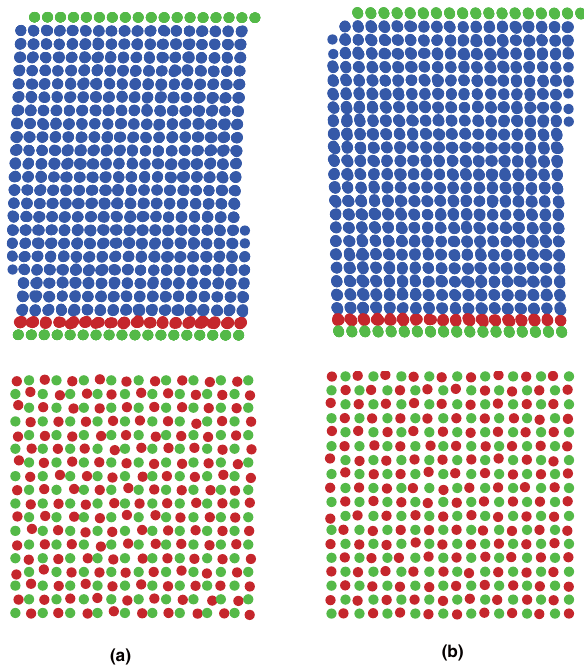
Fig. 4 Atomistic structures ( x – z side view and x – y bottom view) of the tribological system at  (a) 0.6 and (b) 0.7. The wall, the elastic substrate, and the fluid atoms are represented by the green, blue, and red spheres,